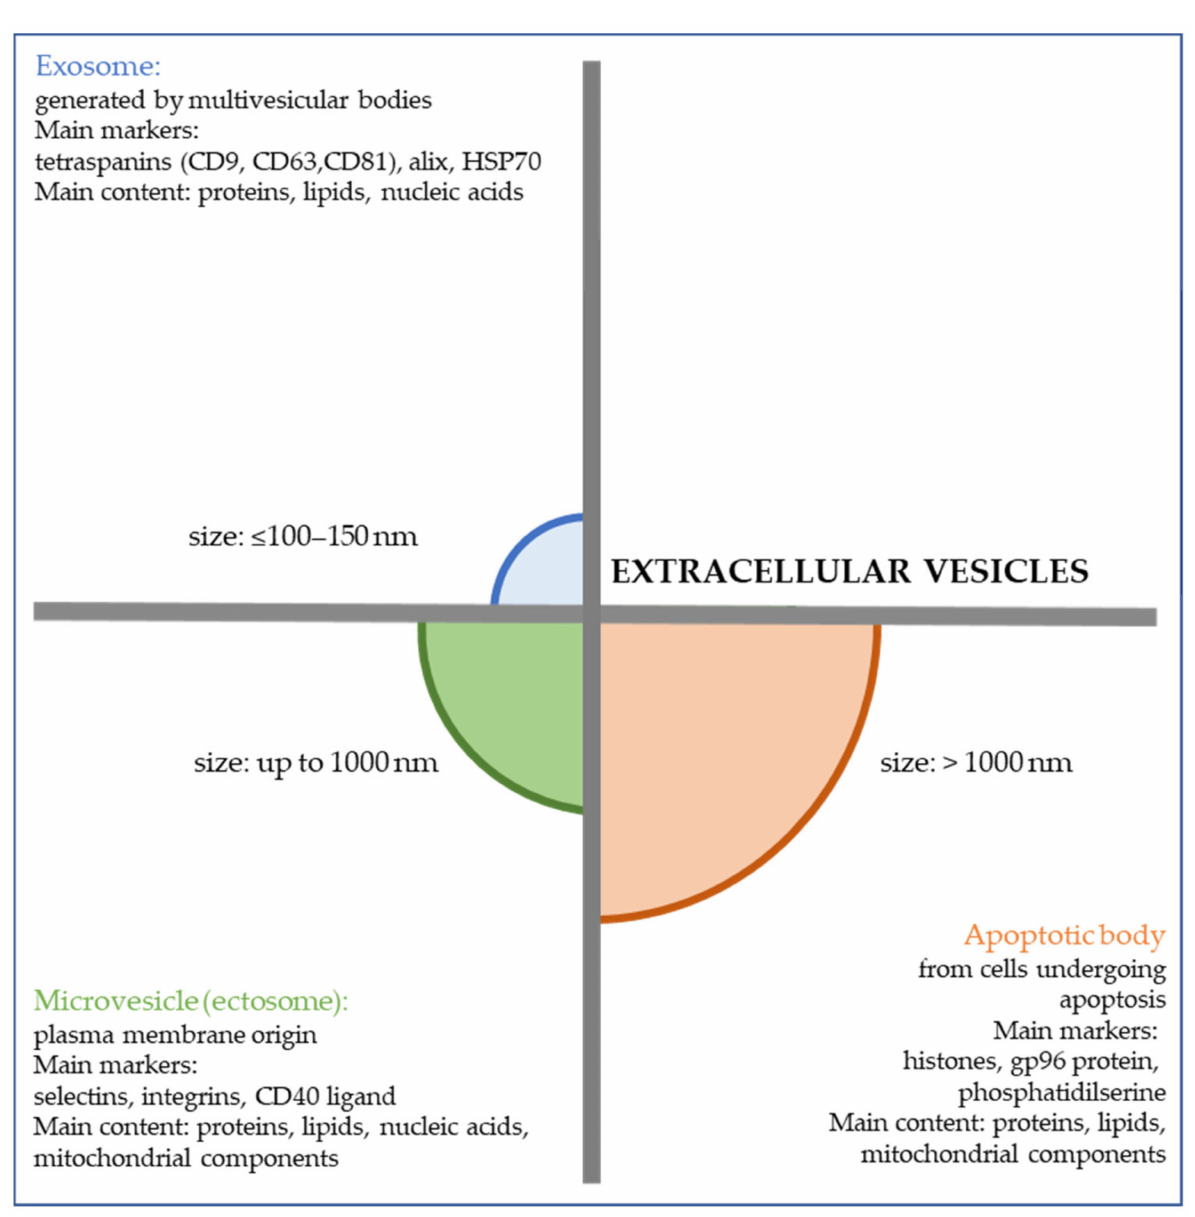
Figure 1. Main characteristics of the three major subpopulations of extracellular vesicles: exosomes, microvesicles, and apoptotic bodies in terms of size, biogenesis, main markers, and content